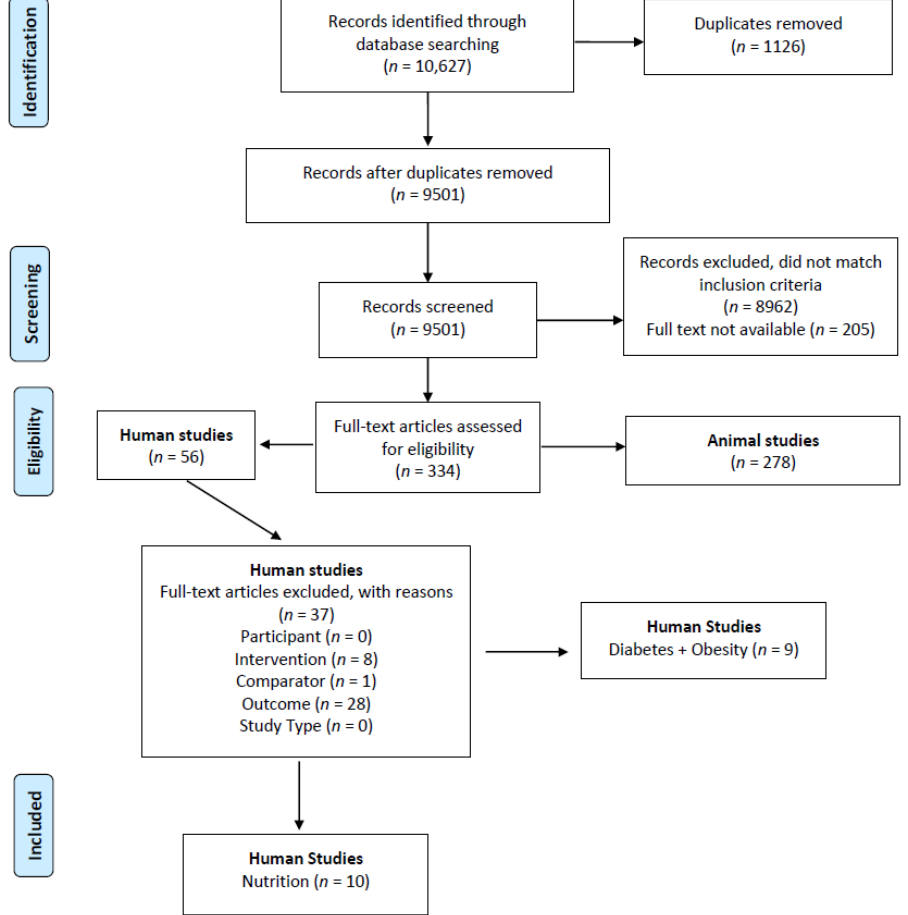
Figure 1. Preferred Reporting Items for Systematic Reviews and Meta-analysis (PRISMA) flow diagram of the study selection process.